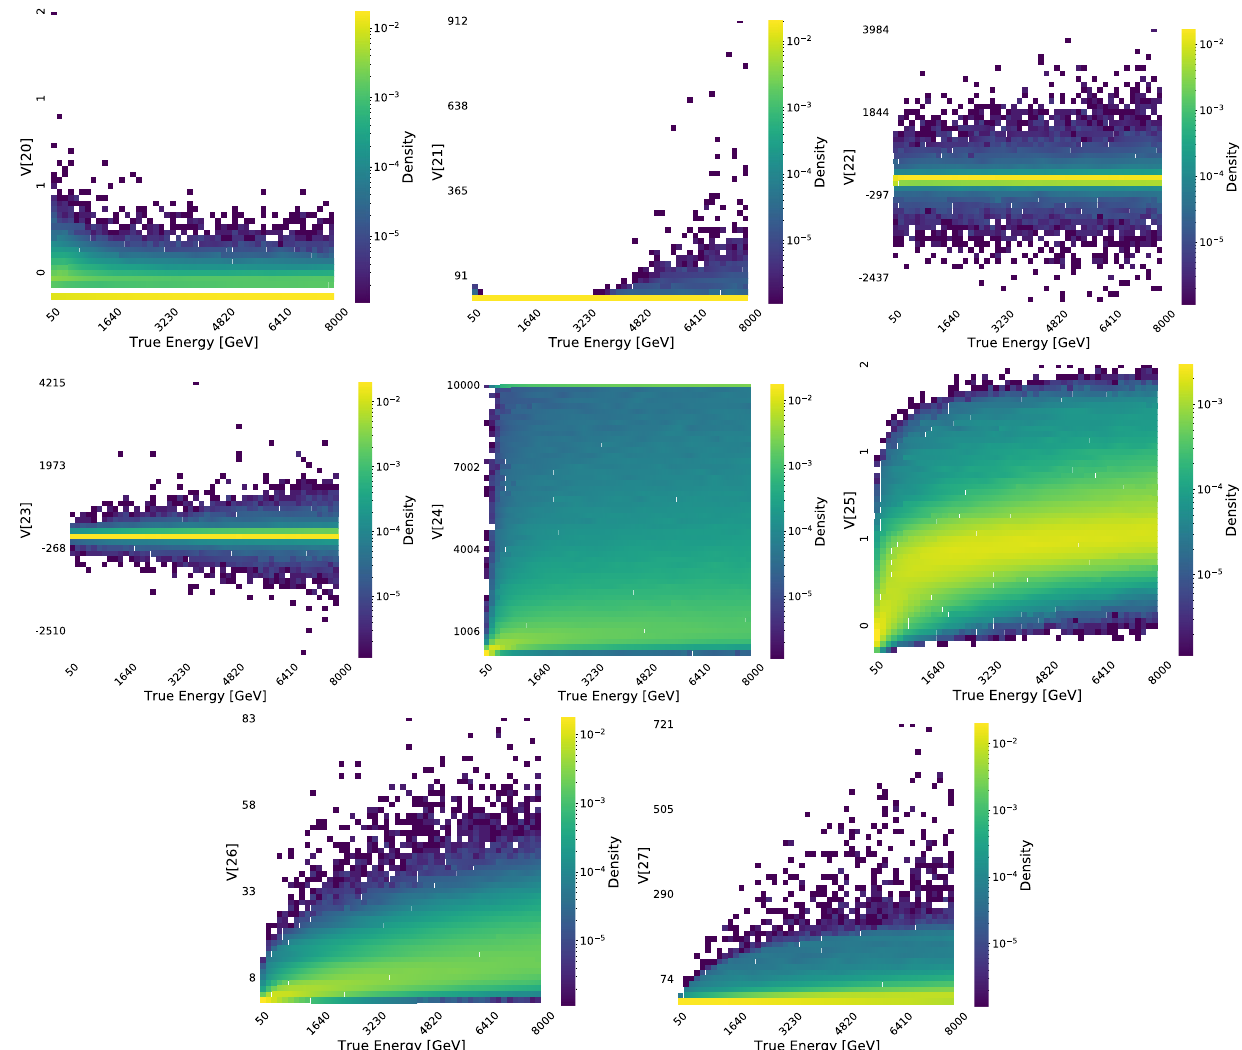
Fig. 20 2D histograms showing the dependence of features V[20] to V[27] (on the y axes) on true muon energy (on the x axes). Features are defined in Sect.